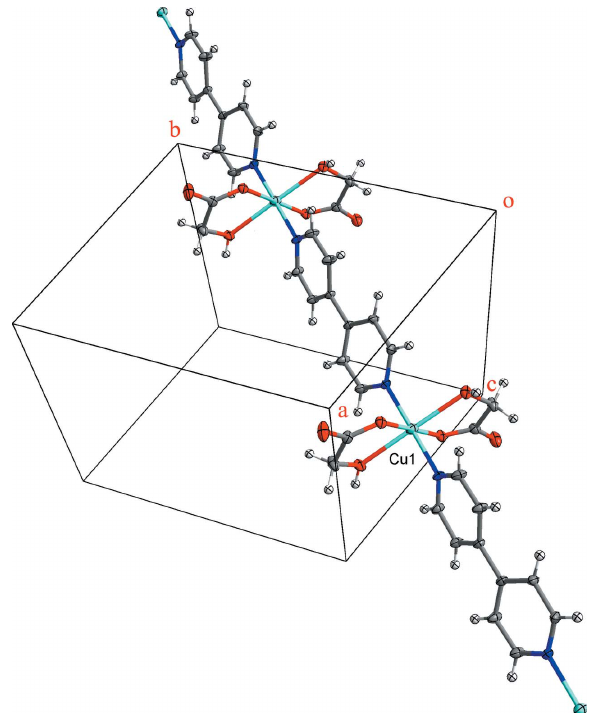
Figure 2 One-dimensional structure of the title polymer constructed by 4,4 0 -bipy ligands bridging the Cu II ions along the [110] direction. The solvate ethane-1,2-diol molecules have been omitted for clarity.